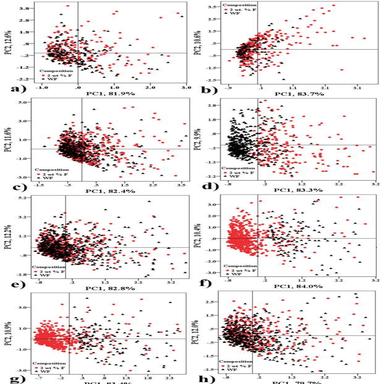
Score plots in the space of maximal variance of the morphology parameters used to describe cavitation erosion for a) 3 min, b) 9 min, c) 18 min, d) 24 min, e) 30 min, f) 36 min, g) 42 min and h) 60 min.